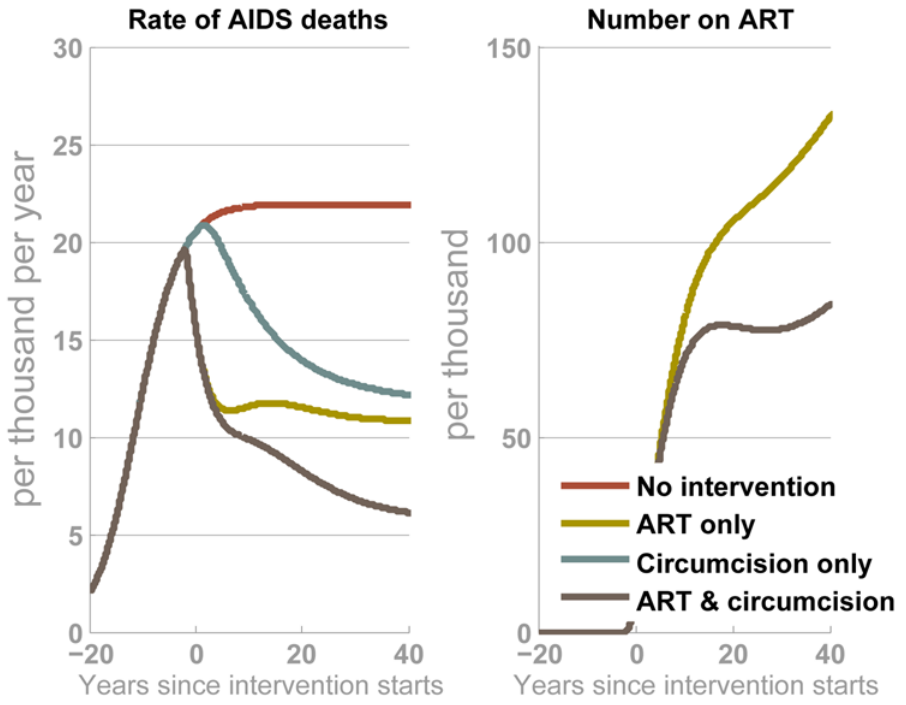
Figure 5. Comparison of circumcision interventions and ART. Four epidemic projections show (i) no interventions (red line), (ii) ART provided to up to 90% of those in need (yellow line), (iii) circumcision intervention with 90% coverage (blue line), (iv) both the ART and the circumcision intervention (brown line). The outputs are the annual rate of AIDS death (per 1000) and the number receiving ART (per 1000 population when the intervention starts). The time-scale relates to years since the circumcision intervention starts. The fraction of individuals that can start treatment increases from 0% two years before the circumcision intervention starts (which we take to be approximately equal to calendar year 2005) to 28% within two years (i.e. 2007) – this is typical for sub-Saharan Africa [42]. We assume that ART coverage will plateau at 90% by